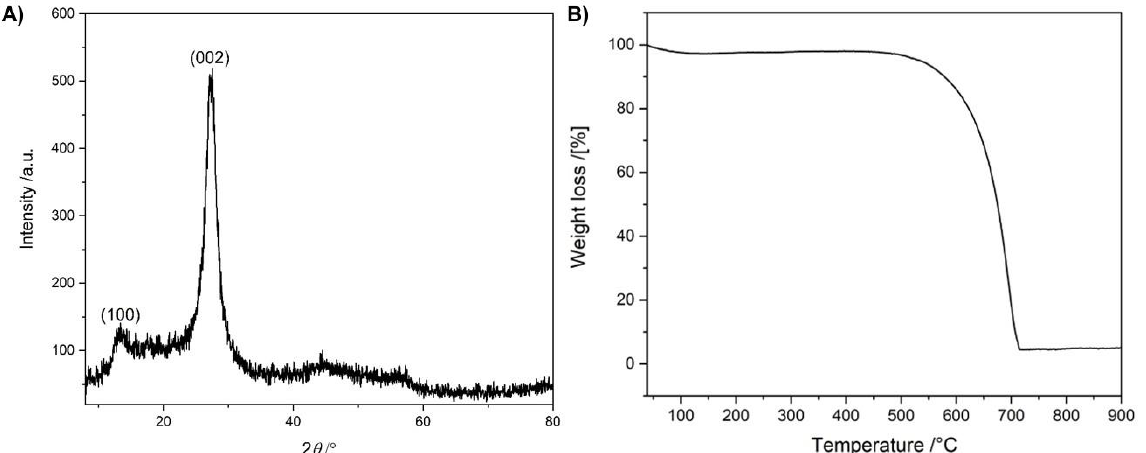
Figure 3. ( A ) X-ray diffractogram and ( B ) TGA analysis of g -C 3 N 4 .